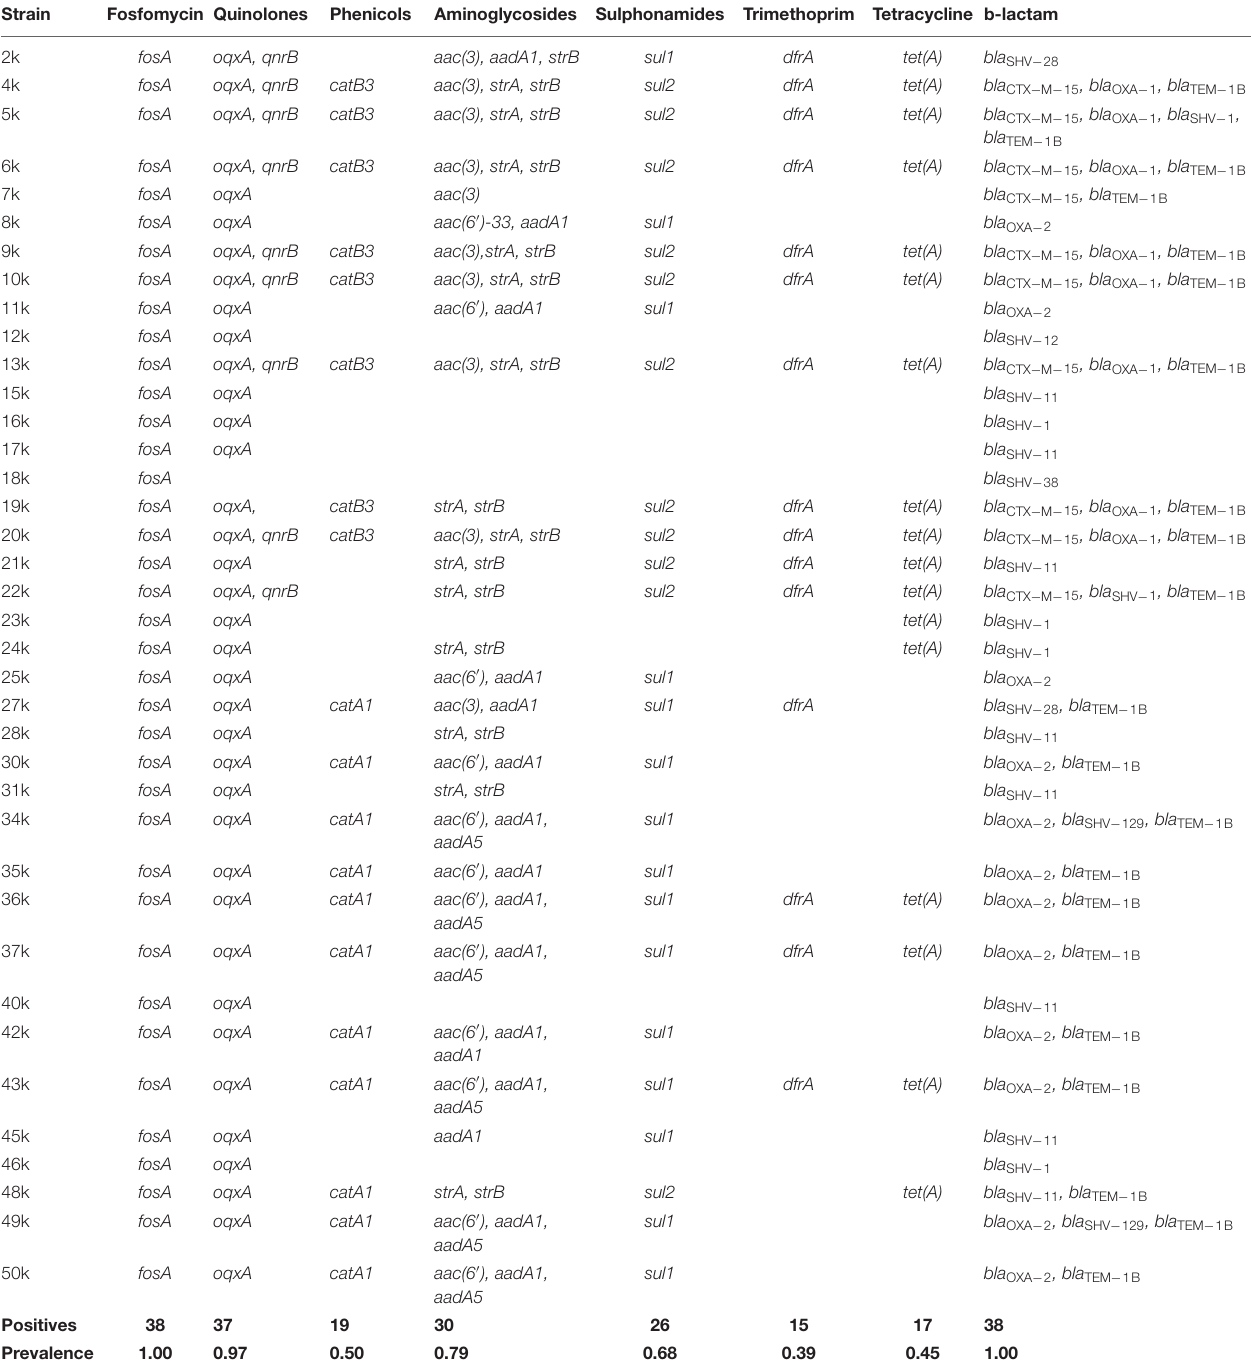
TABLE 5 | Antibiotic resistance genes in K. pneumoniae strains.